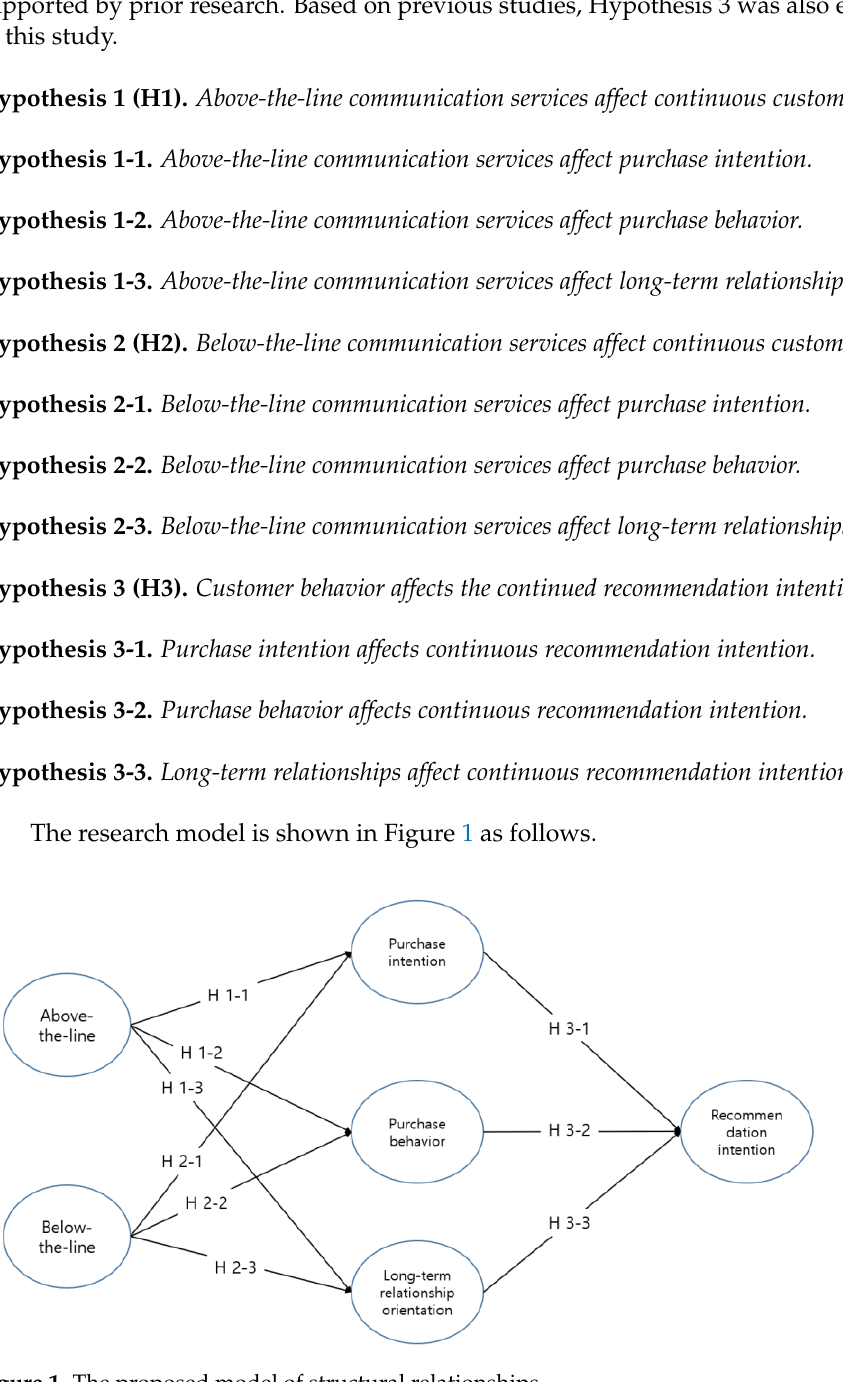
Figure 1. The proposed model of structural relationships.